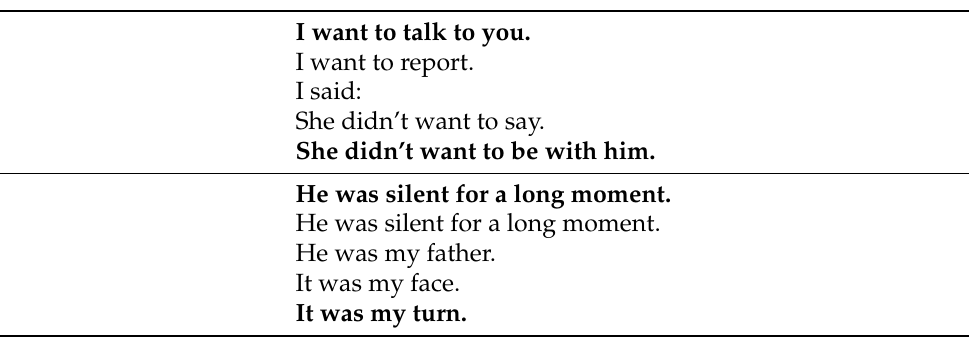
Table 3. Interpolation. First and last sentence ( bold ) were given as the input to the VAT. Intermediate sentences were obtained by tokenwise linear interpolation between the two latent representations padded to the same length.